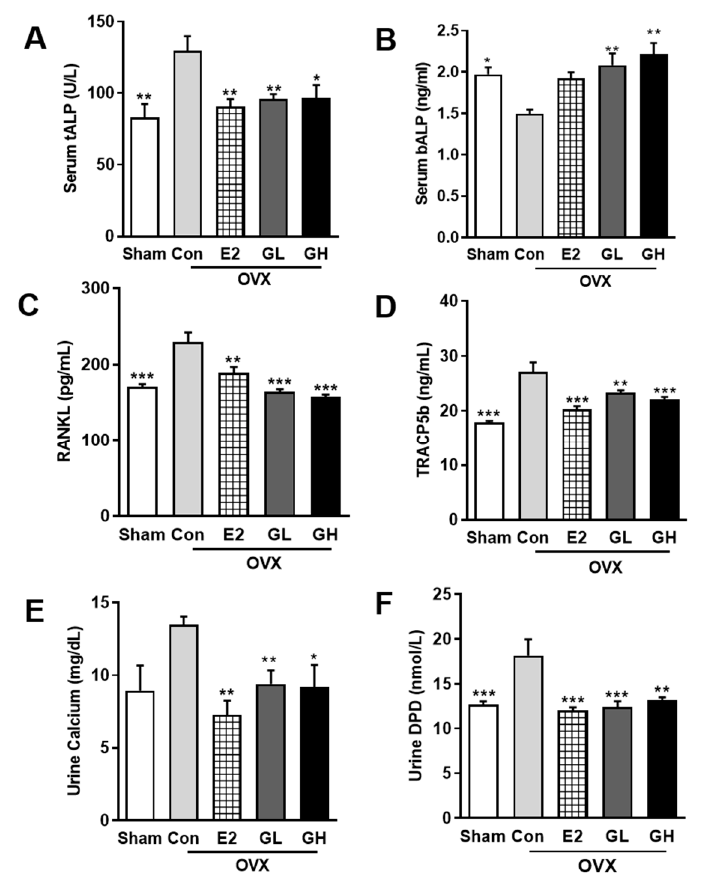
Figure 4. Effect of GTE supplementation on markers of osteoblasts and osteoclasts in serum and urine. Measurements of serum total alkaline phosphatase (tALP) ( A ), bone alkaline phosphatase (bALP) ( B ), receptor activator of nuclear factor kappa-B (RANKL) ( C ), and tartrate-resistant acid phosphatase 5b (TRACP5b) ( D ). Measurements of urine calcium ( E ) and deoxypyridinoline (DPD) ( F ). Results are expressed as means ± SEM. *** p < 0.001, ** p < 0.01, * p < 0.05, significantly different from Con.